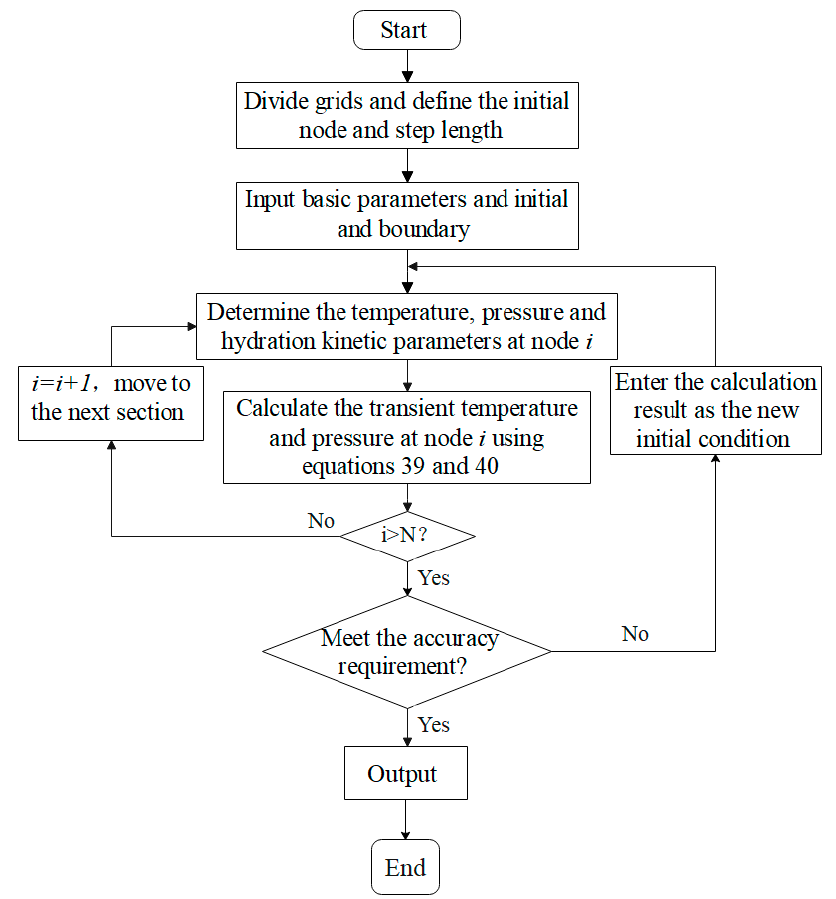
Figure 5. Calculation flowchart of the pressure loss prediction model.